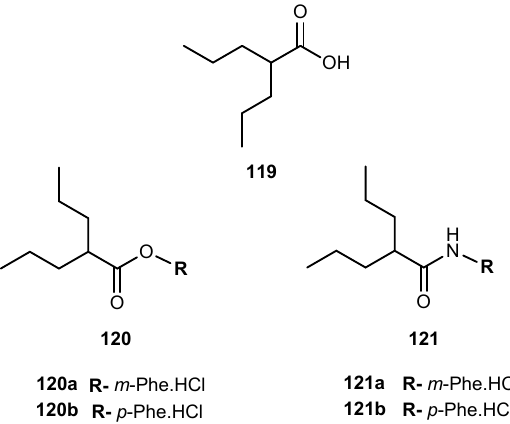
Figure 48. L -Phenylalanine amide ( 121a – b) and ester prodrugs ( 120a – b) of valproic acid ( 119 ) .